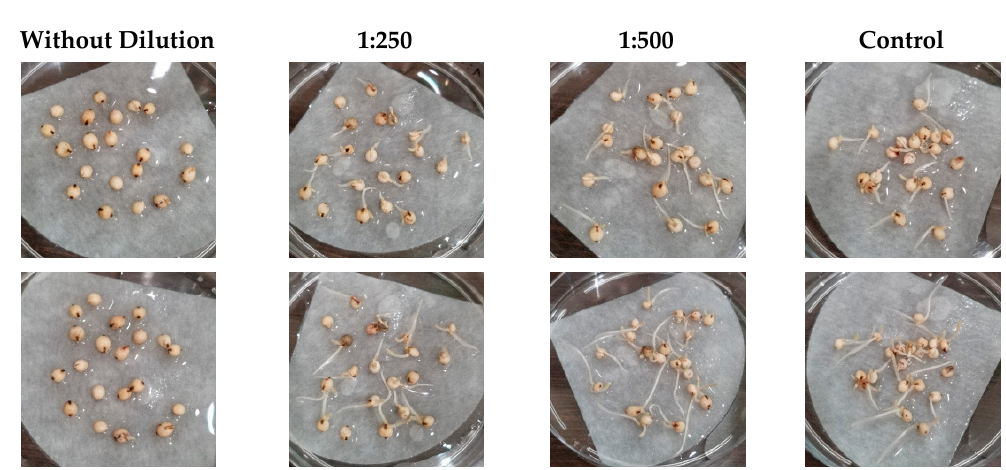
Figure 3. Photographs of sorghum seedlings at different dilutions of activated water and soaking times.